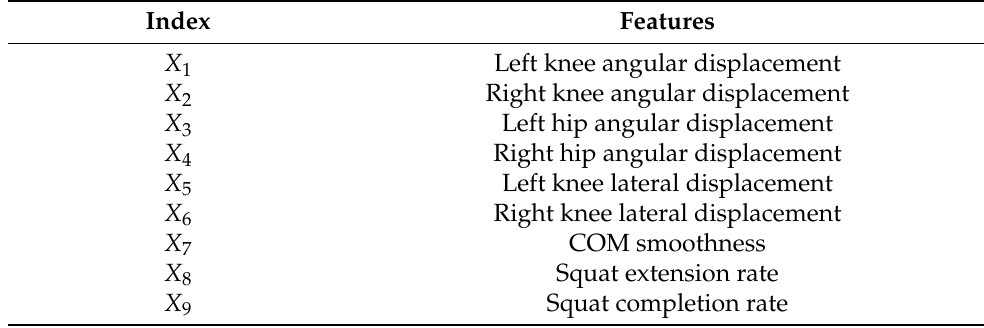
Table 2. Inputs to the neural network considered for the squat motion